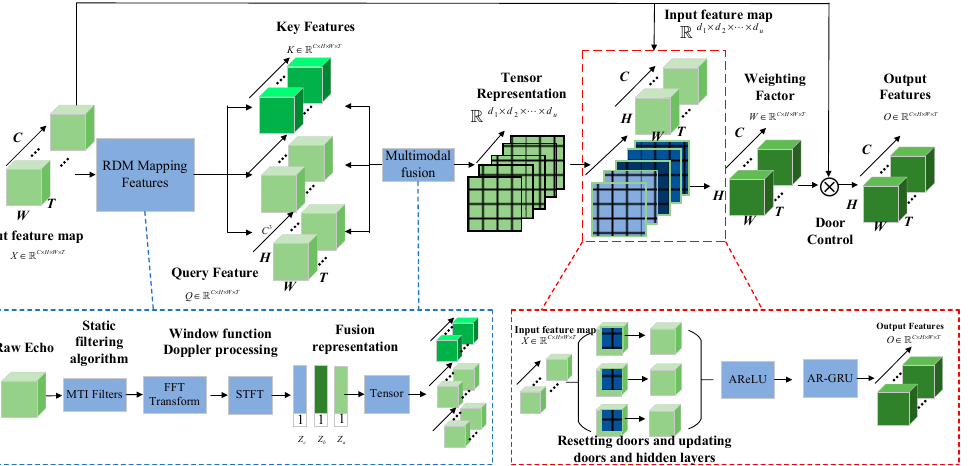
Figure 3. Behavior recognition model with low-rank fusion weight analysis of multicascade Dop- Figure 3. pler features.